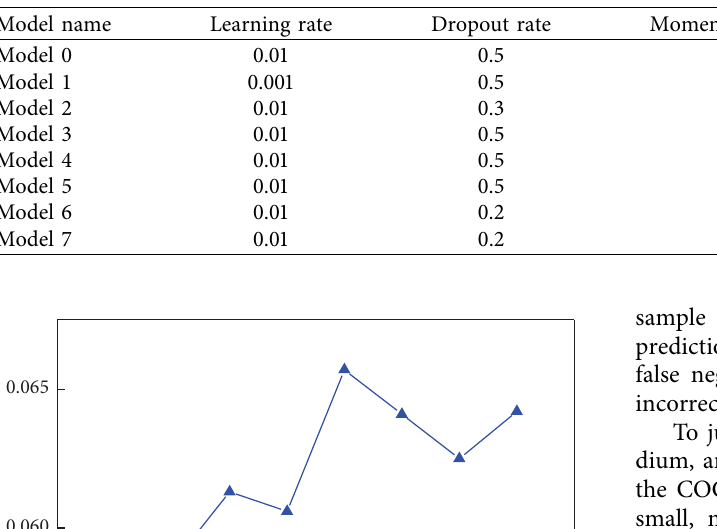
Table 1: Model parameters.